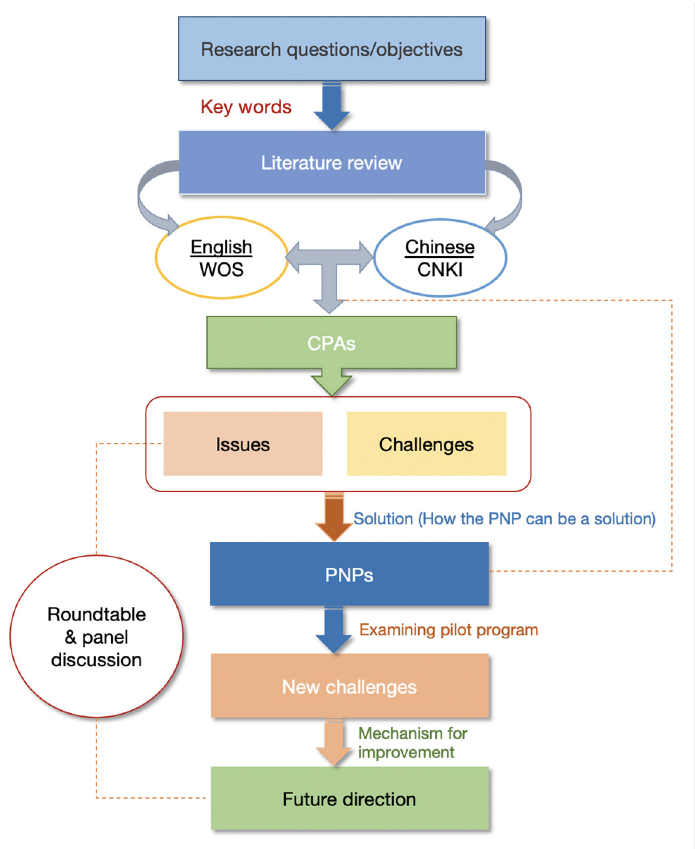
Figure 1. The research framework.